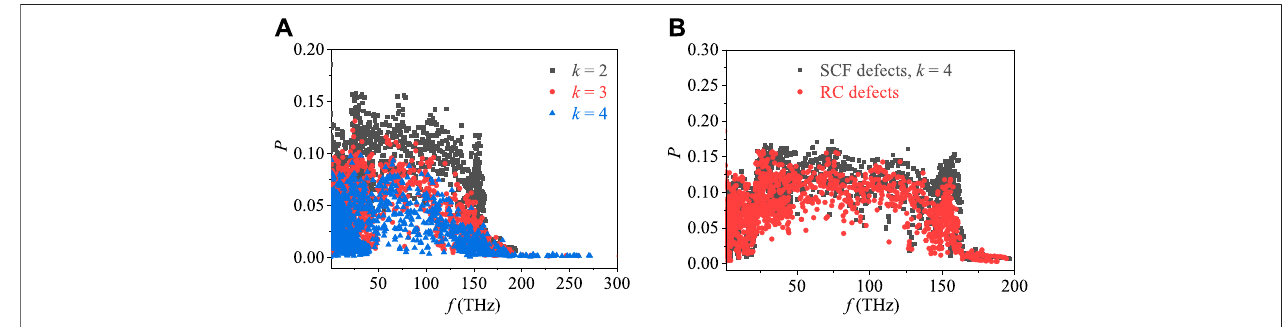
FIGURE 4 | Phonon participation rate of graphene with SCF and RC defects: (A) effect of fractal level and (B) comparison between SCF and RC